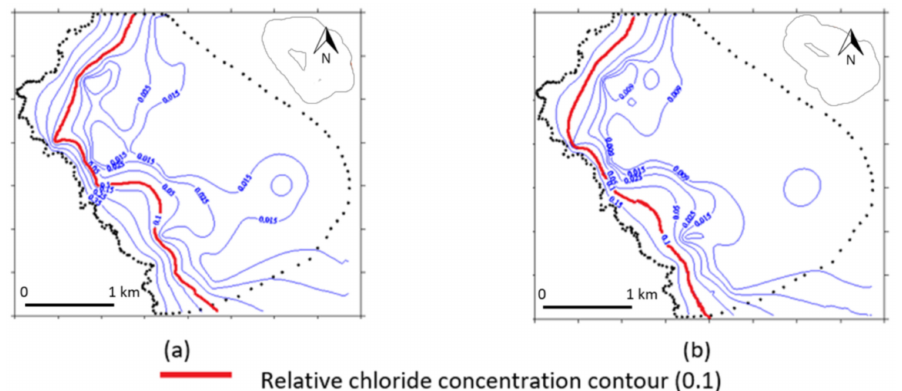
Figure 5. Results of numerical simulations for Pegeia pilot area: Relative chloride concentrations ( a ) for the base hydrological year (end of dry period), and ( b ) for extreme dry hydrological year, based on the MPI-RCA4 model under the RCP 4.5 scenario (end of dry period). Relative chloride concentration of 1 expresses the seawater chloride concentration (22 g /